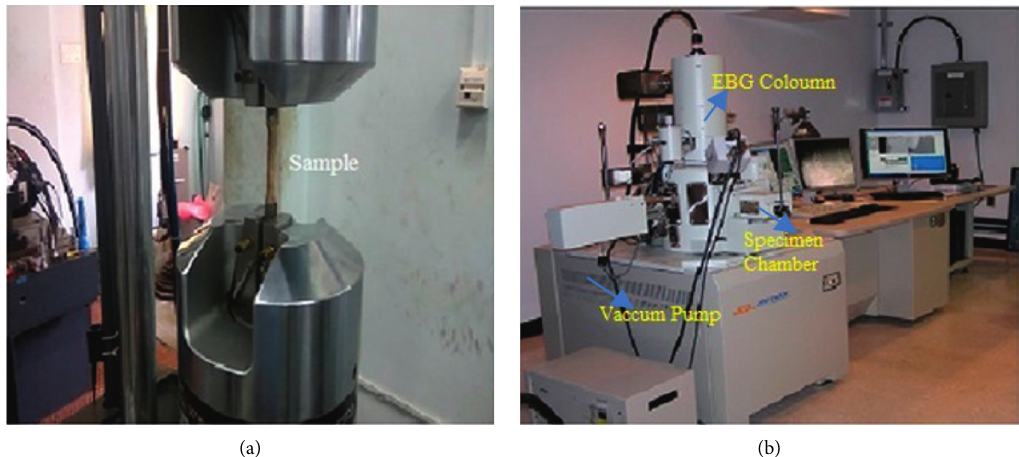
Figure 2: Experimental setup of (a) tensile test and (b) scanning electron microscopy analysis.